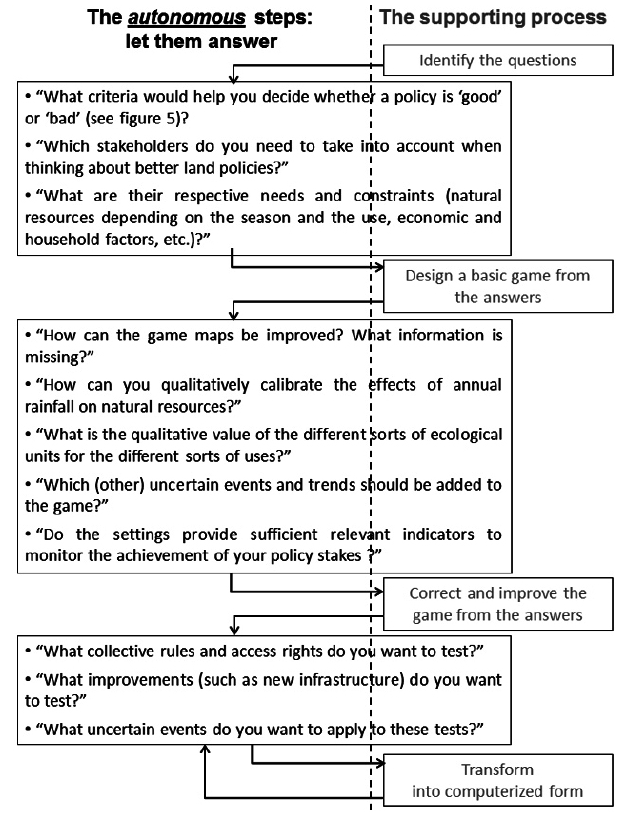
Fig. 4 . The specific participatory position in the self-design